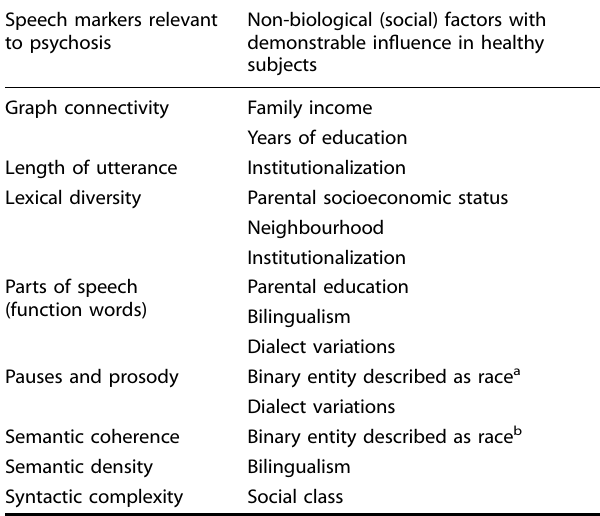
Table 1. Social factors with reported in fl uence on quantitative speech